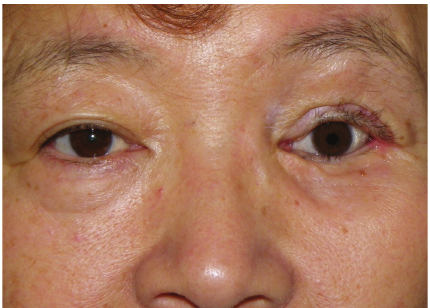
Figure 8: Postoperative view at 17-months followup (Case